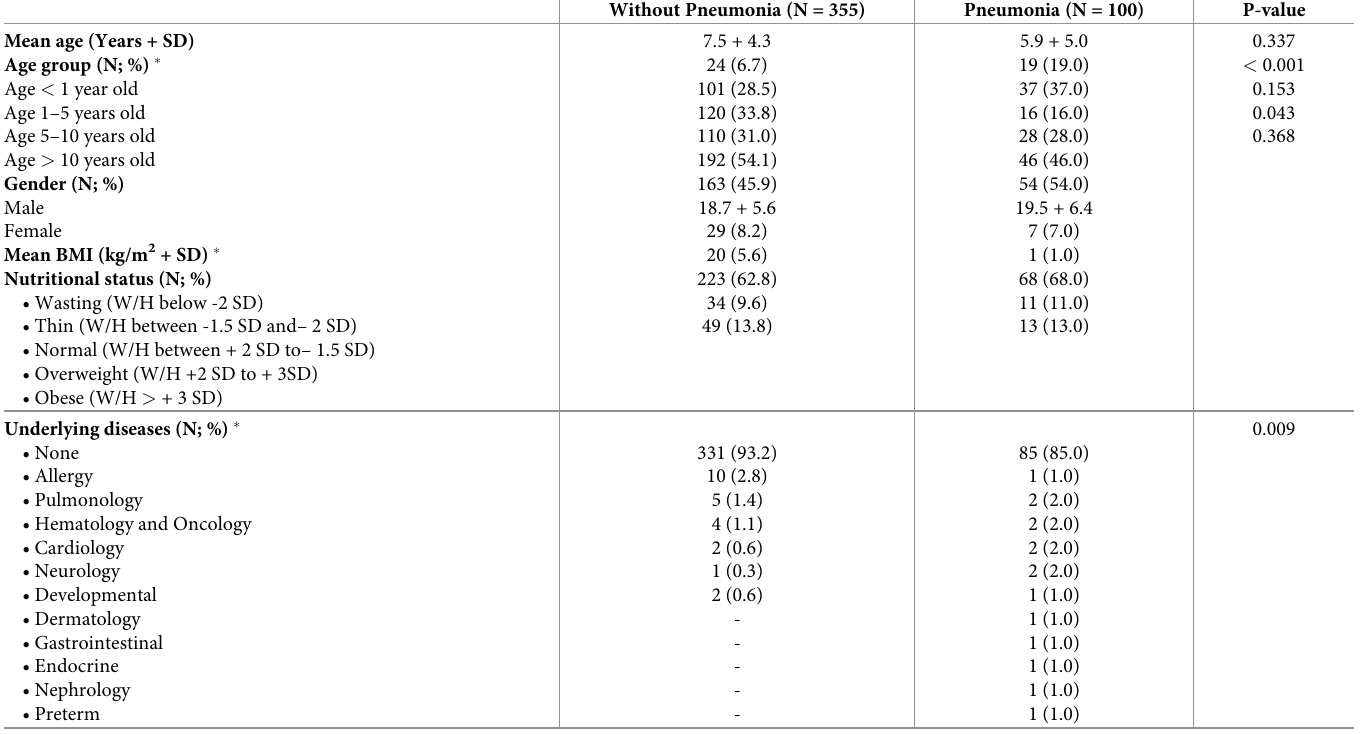
Table 4. Demographic data based on diagnosis of radiographic